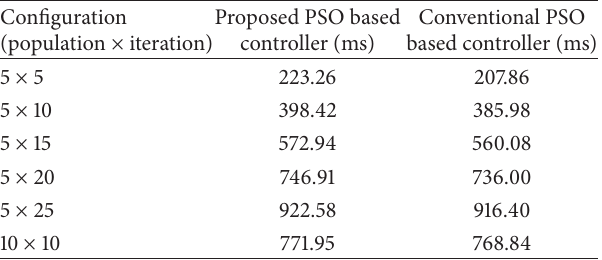
Table 3: Execution time of the considered